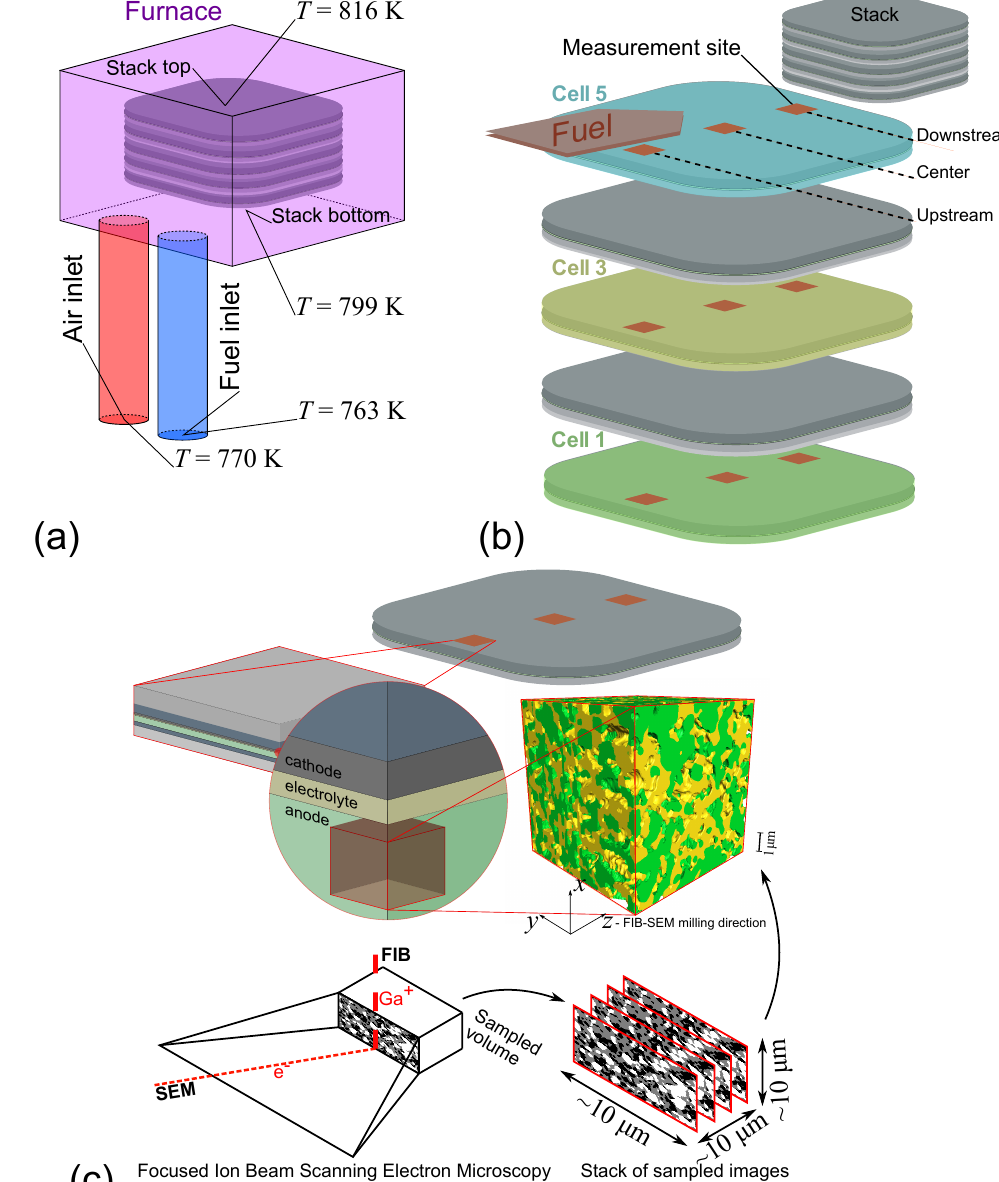
Figure 1. Sample recovery from the disassembled stack ( a ) SOFC stack, ( b ) Sample locations, ( c ) FIB- SEM